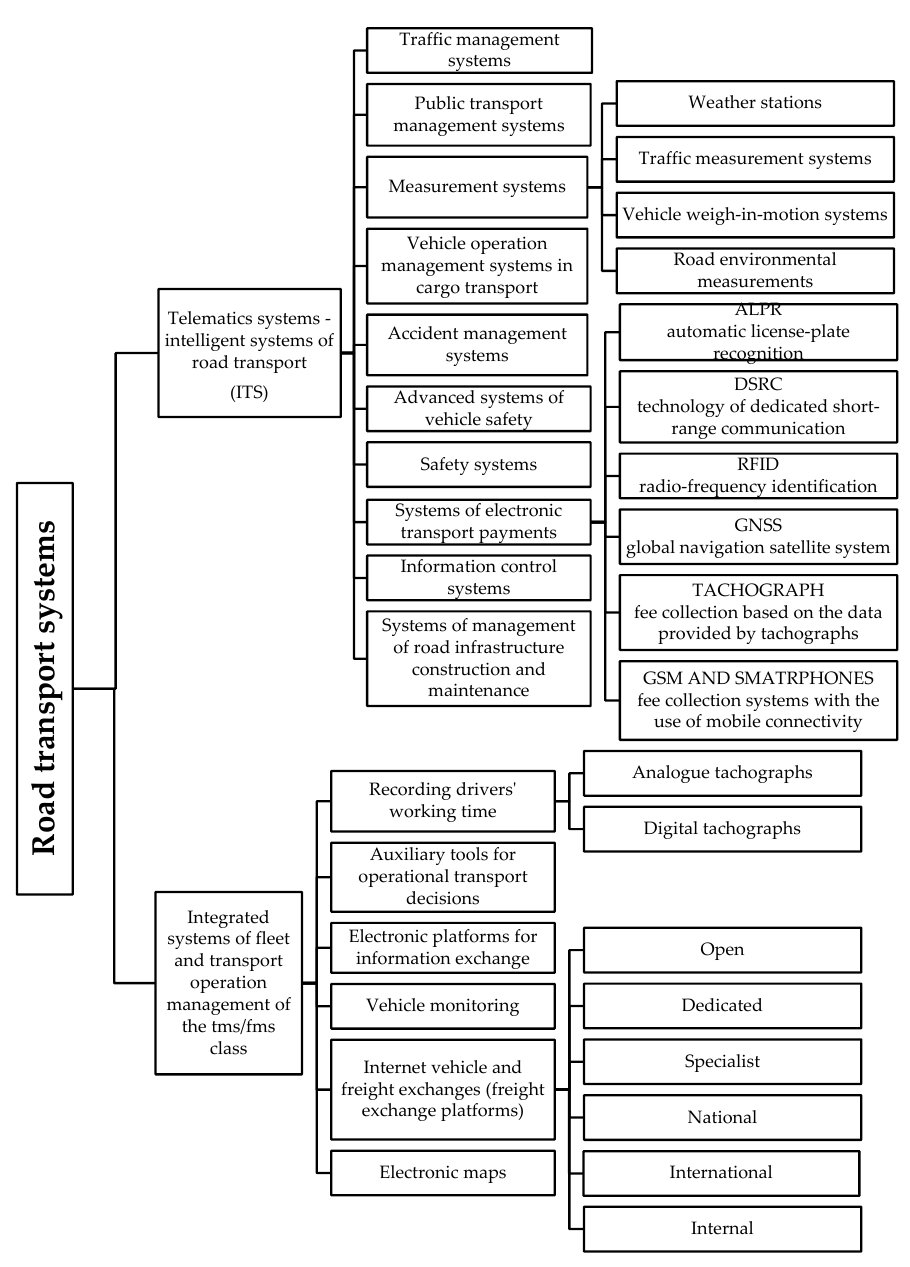
Figure 1. IT (information technology) systems supporting operation of road transport.